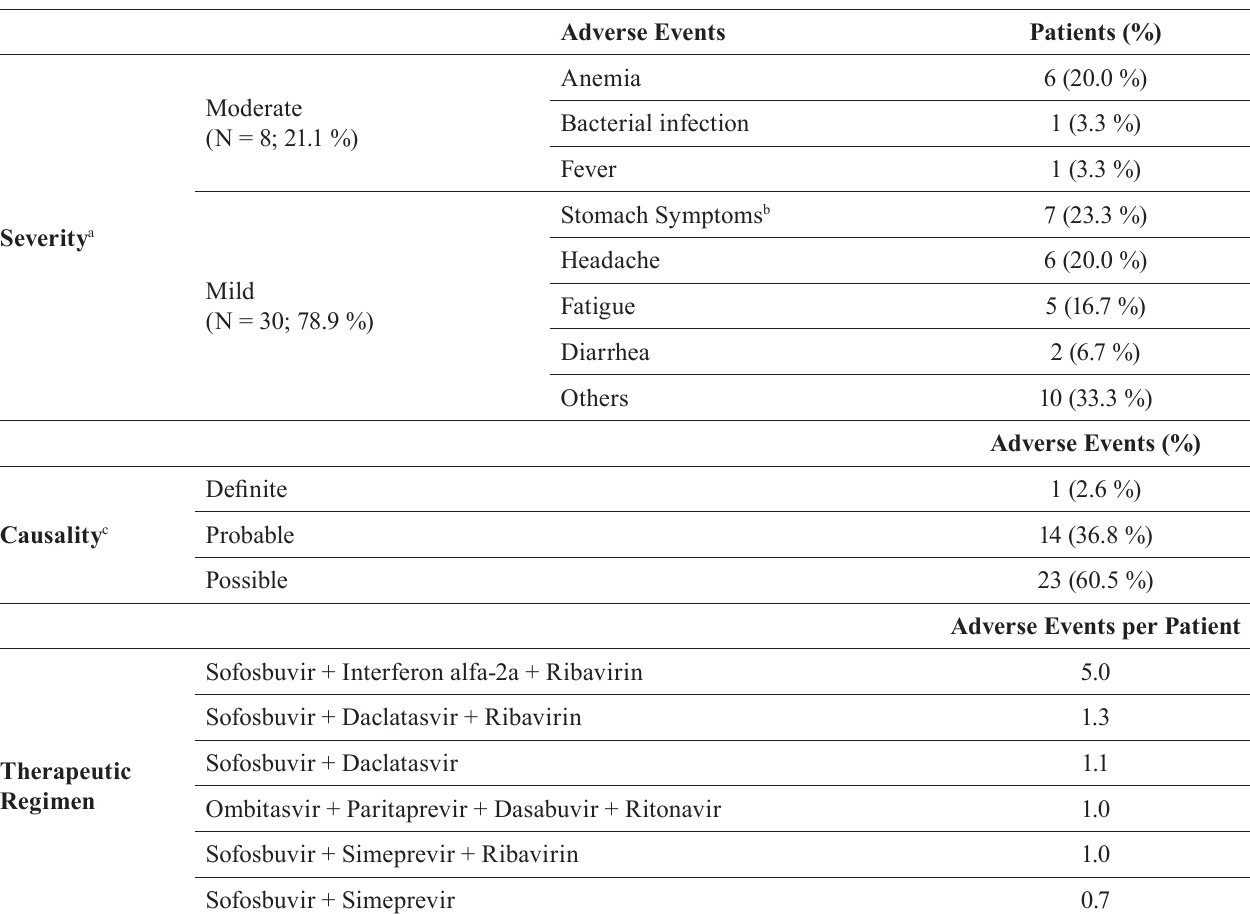
TABLE II – Classification of adverse events of Hepatitis C treatment of patients attended by the Specialized Pharmacy of Londrina between June 2017 and June 2018 (N =